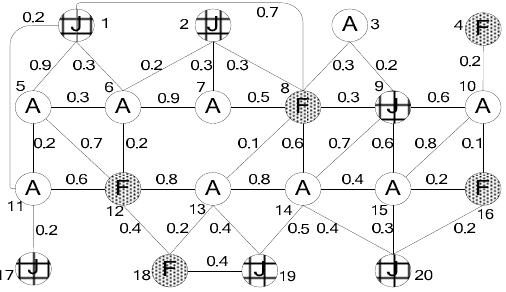
Figure 1. Example of undirected weighted labeled graph G.